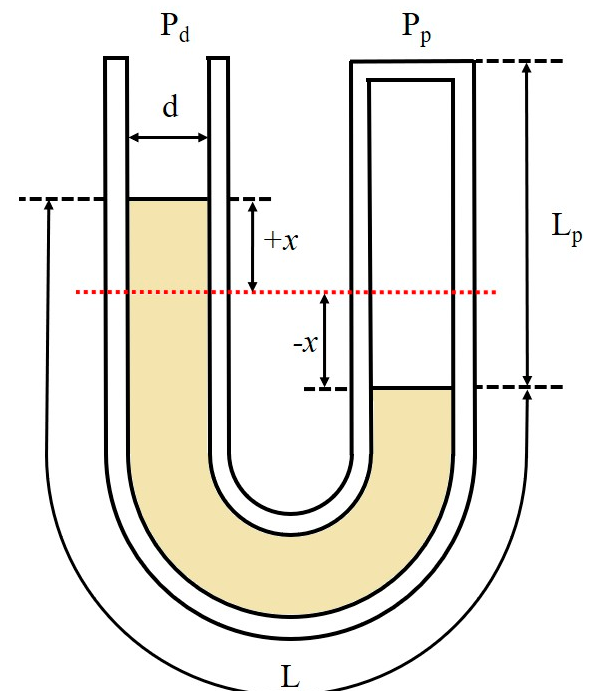
Figure 7. Illustration of a U-tube liquid piston oscillation system. (1) Rotary displacer; (2) bath #2, as the waste heat sink; (3) bath #1, as simulated heat source; (4) oscillatory liquid piston conditioning unit; (5) bath #3, associated with evaporator section; (6) bath #4, associated with condenser section; (7) data acquisition system; (8) personal computer.